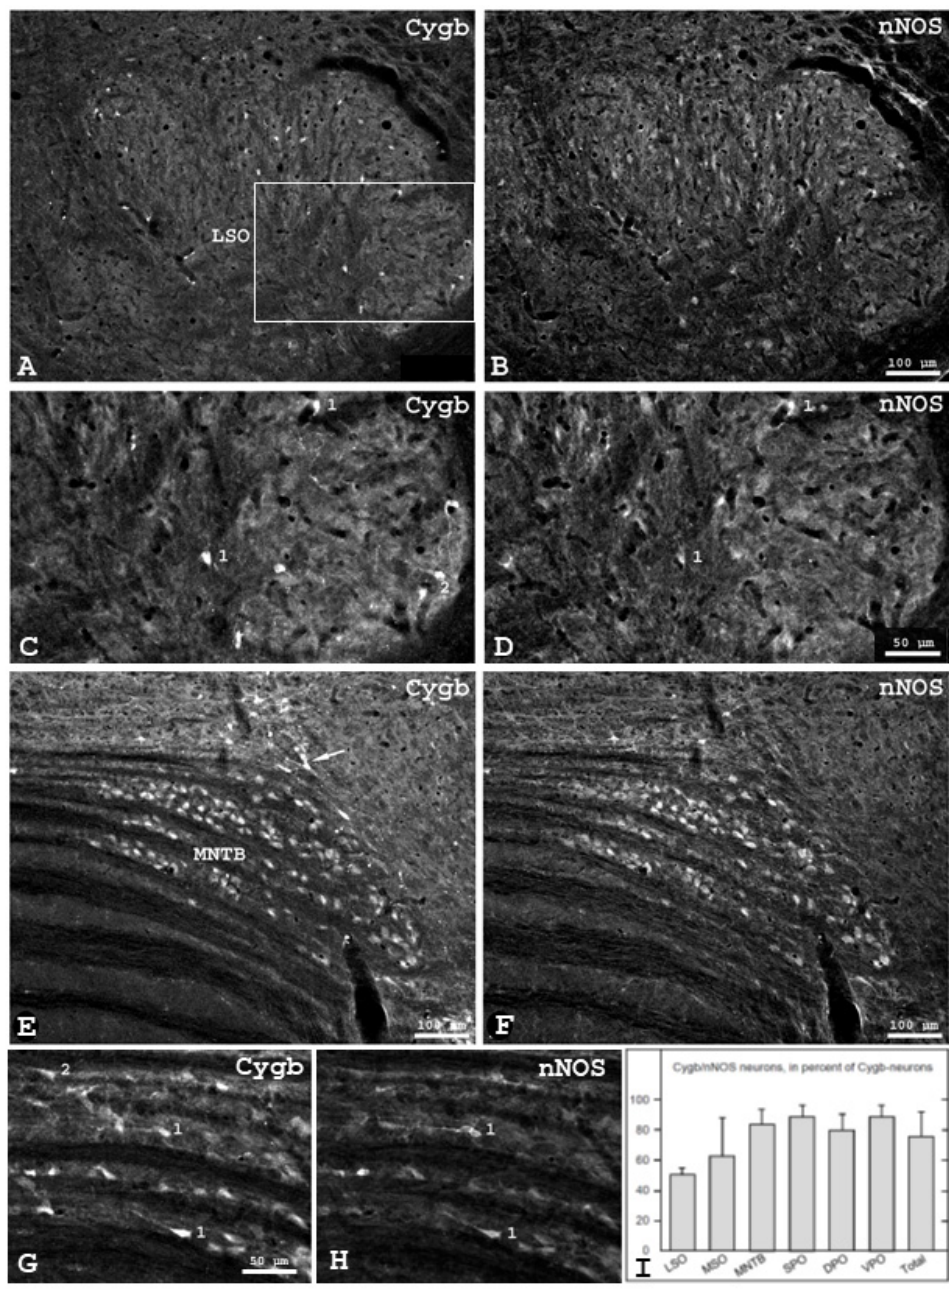
Figure 3. Distribution of cytoglobin (Cygb) and neuronal nitric oxide synthase (nNOS) immunofluores- cence in the right SOC of the mouse (frontal plane). ( A , B ): Some immunoreactive neurons are seen in LSO and in periolivary regions. The boxed region in ( A ) is shown in higher magnification in ( C , D ). Double- immunoreactive neurons in the lateral superior LSO region (exemplarily labelled with "1" in ( C , D )), and neurons expressing solely Cygb (“2”) or nNOS were present. ( E , F ): Cygb- and nNOS-immunofluorescence in the right medial nucleus of the trapezoid body (MNTB) of the mouse. The majority of large neurons show colocation of Cygb and nNOS. Strikingly, a group located at the dorsal edge of the MNTB (arrow in ( E )) contains predominantly Cygb-positive, nNOS-negative neurons. ( G , H ): Magnifications of the medial portion of the MNTB in an adjacent section show both substances colocated in some neurons (exemplarily marked with "1"), while others ("2") contain only Cygb. ( I ): Double-labeled neurons in the SOC subregions in percent of Cygb-neurons (mean ± SD, n = 5).